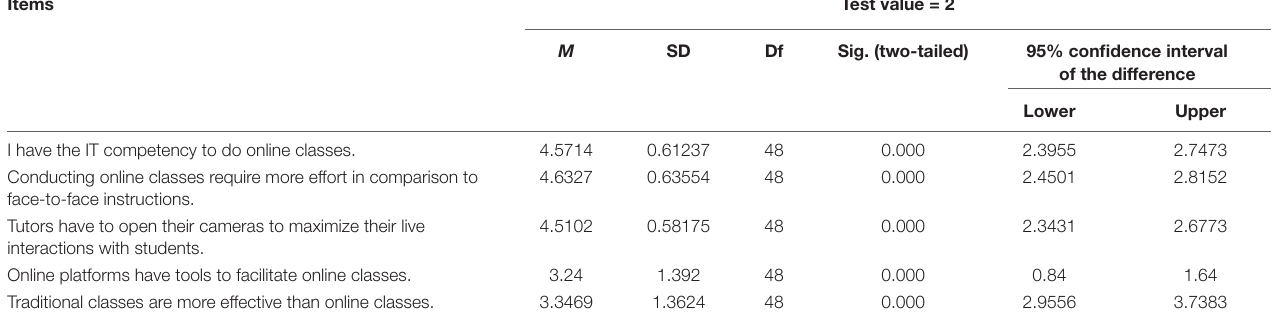
TABLE 2 | Attitude of IT skills and online class preparations.